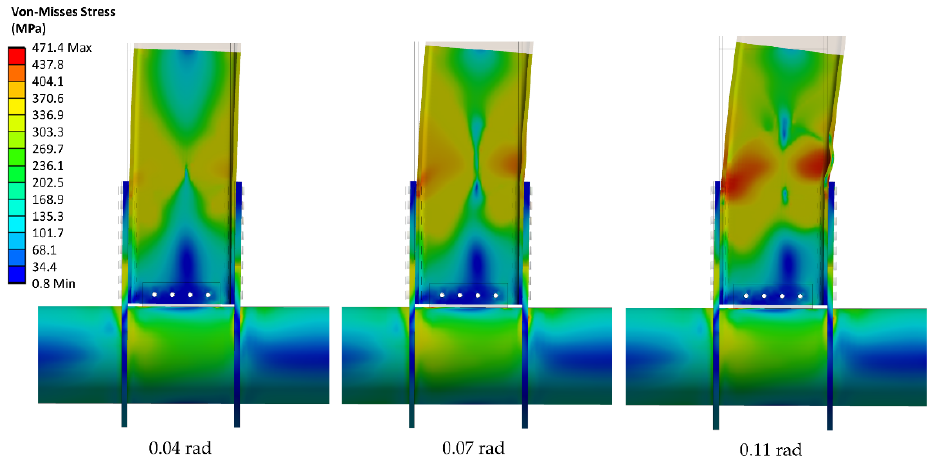
Figure 13. Plasticization mechanism exhibited by the numerical model under monotonic displace- ment.